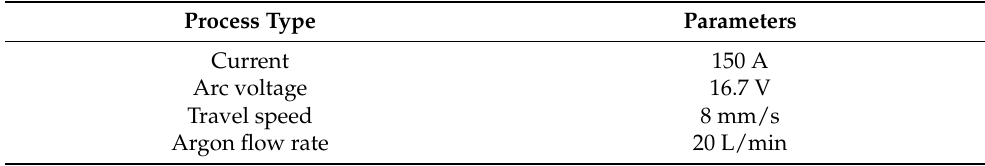
Table 2. Initial process parameters of Al-Mg